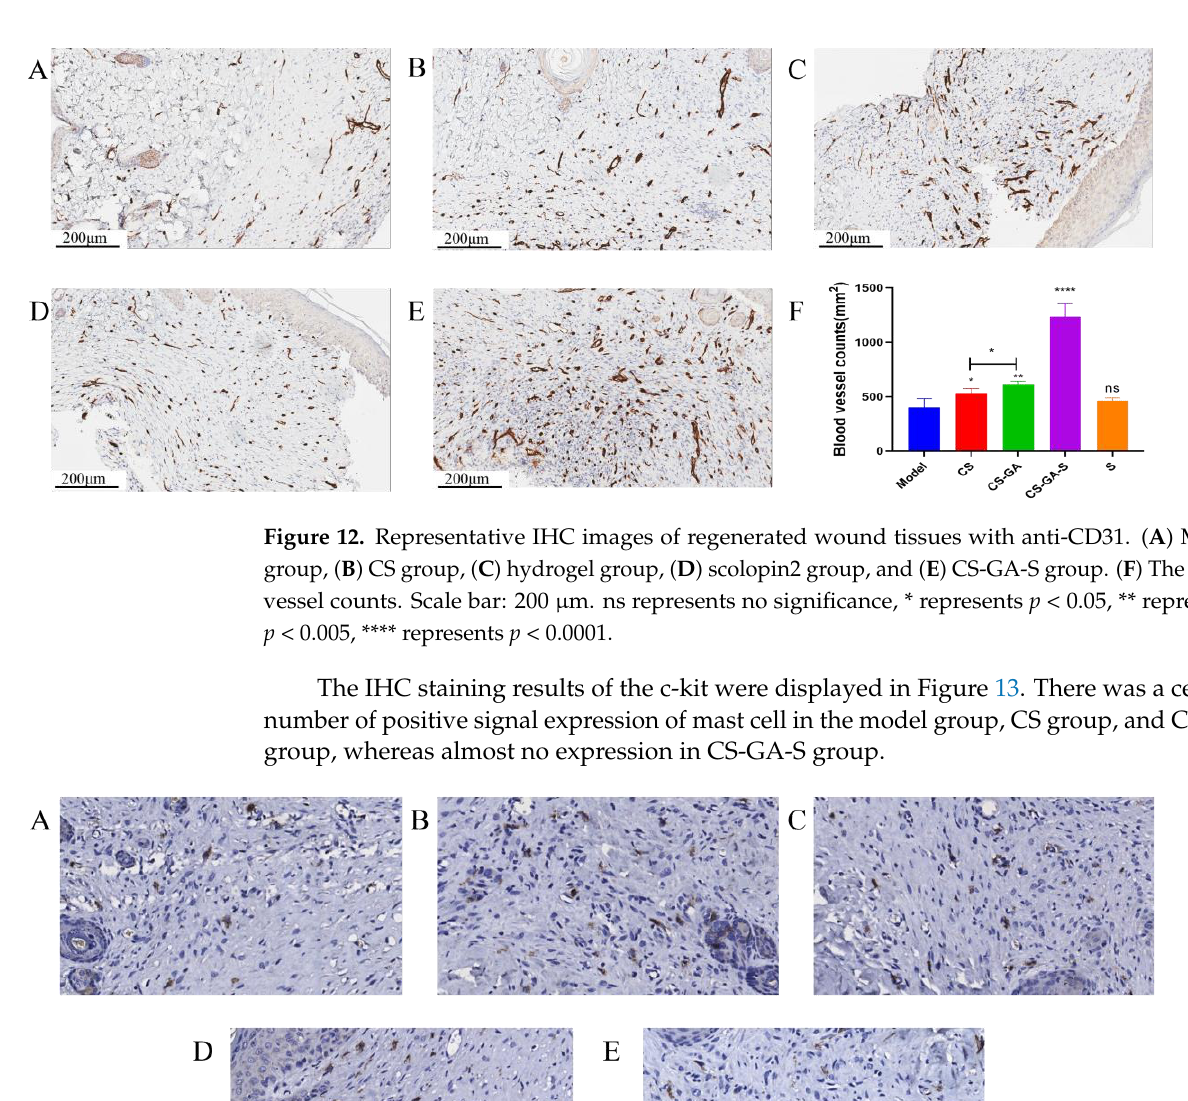
13 of 23 Figure 11. Masson staining microscopic images of skin. ( A ) Model group, ( B ) CS group, ( C ) hydrogel group, ( D ) scolopin2 group, and ( E ) CS-GA-S group. ( F ) The collagen volume fraction (CVF). Scale bar: 300 μm. ns represents no significance, * represents p < 0.05, ** represents p < 0.005. 2.3.3. Immunohistochemistry The immunohistochemical (IHC) staining results of CD31 are displayed in Figure 12. Compared to the model group, the CS-GA-S presented a strong positive staining signal of CD31, followed by the hydrogel group, CS group, and scolopin2 group. Importantly, the hydrogel group presented stronger positive staining of CD31 than the CS group. The IHC staining results of the c-kit were displayed in Figure 13. There was a certain number of positive signal expression of mast cell in the model group, CS group, and CS- GA group, whereas almost no expression in CS-GA-S group. The IHC staining results of HSP47 were displayed in Figure 14. Compared to the model group, the CS-GA-S group presented a strong positive staining signal of HSP47, indicating that the CS-GA-S group has more fibroblasts, while the other groups are not